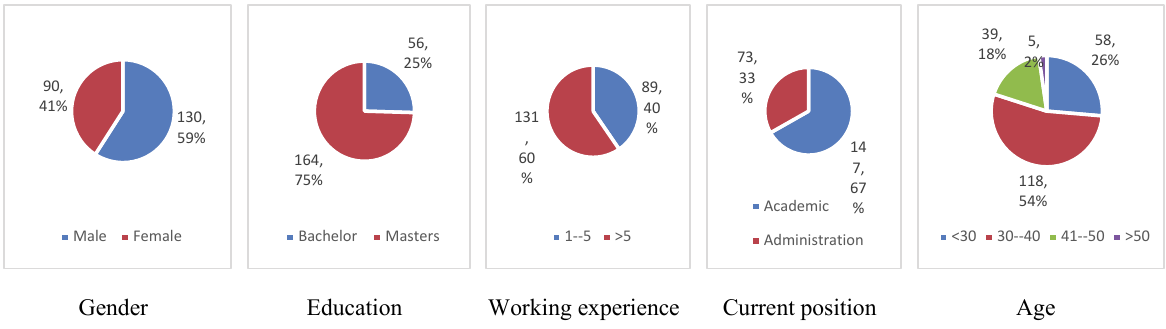
Fig. 2 . Demographic Profile of